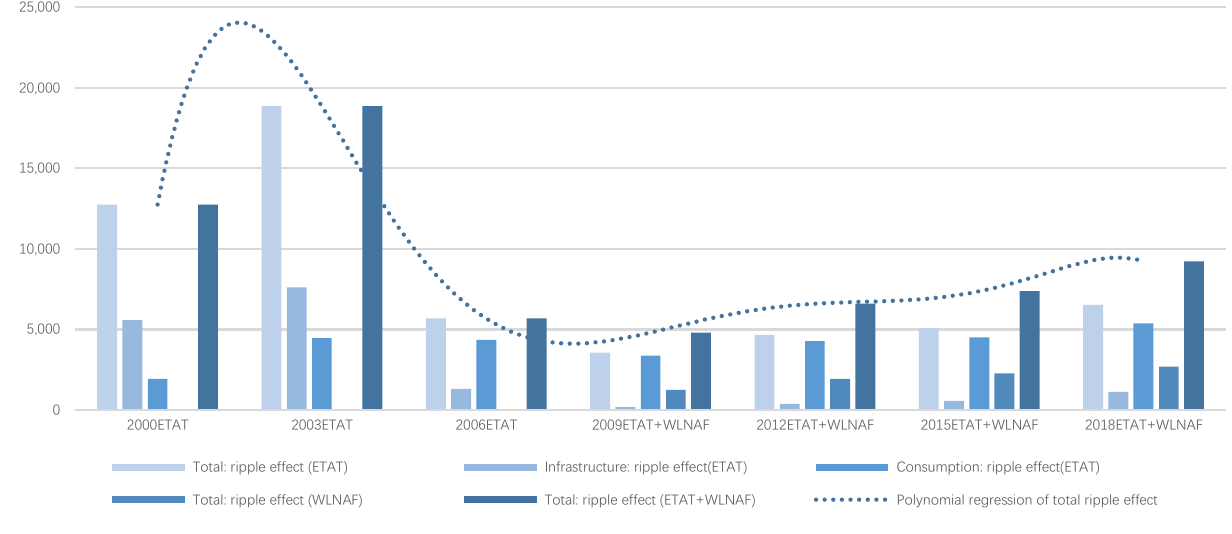
Figure 5. The economic ripple effect of one and two exhibitions in Niigata. Note: The ripple effect (based on the related calculation table for Niigata) is often used colloquially to denote what would be called a multiplier in macroeconomics.